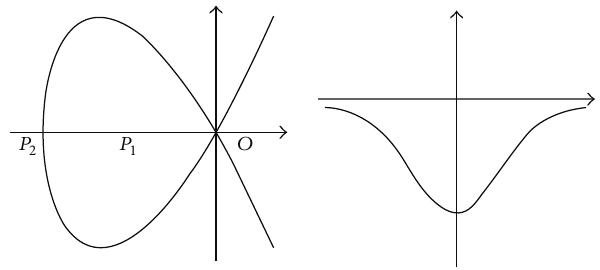
Figure 1: Homoclinic orbit and negative solitary